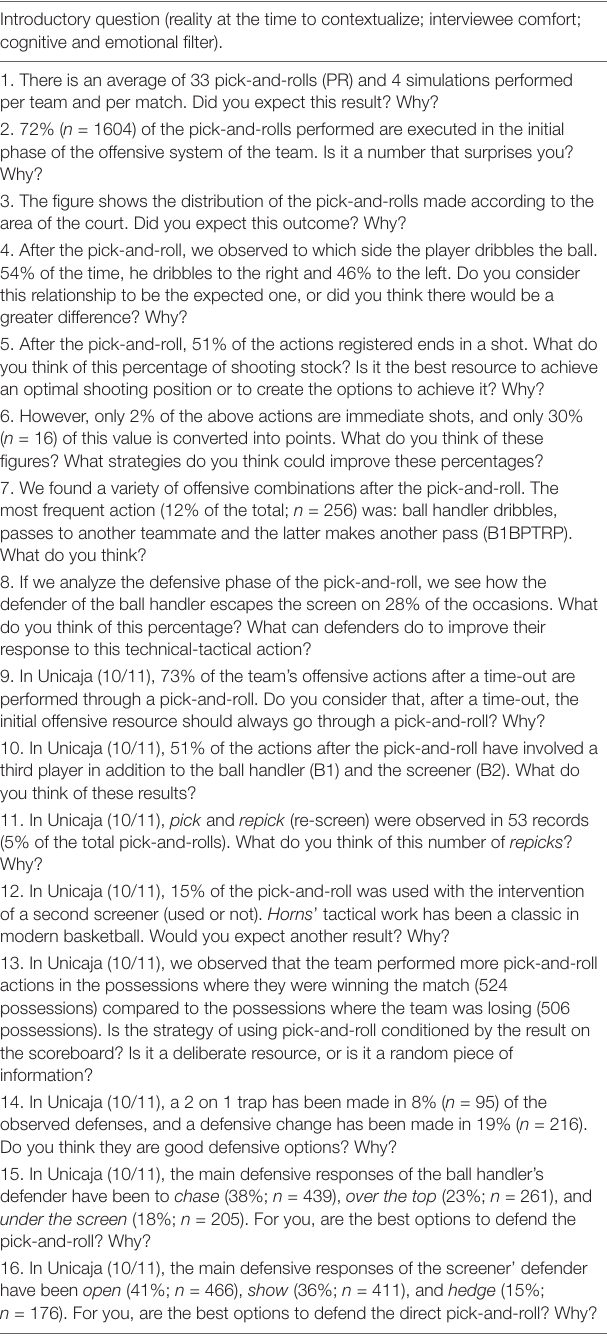
TABLE 1 | In-depth interview questions for basketball experts about the pick-and-roll in the analysis (Nunes, 2020) of Club Baloncesto Málaga (Unicaja Málaga) of the Asociación de Clubes de Baloncesto (ACB)